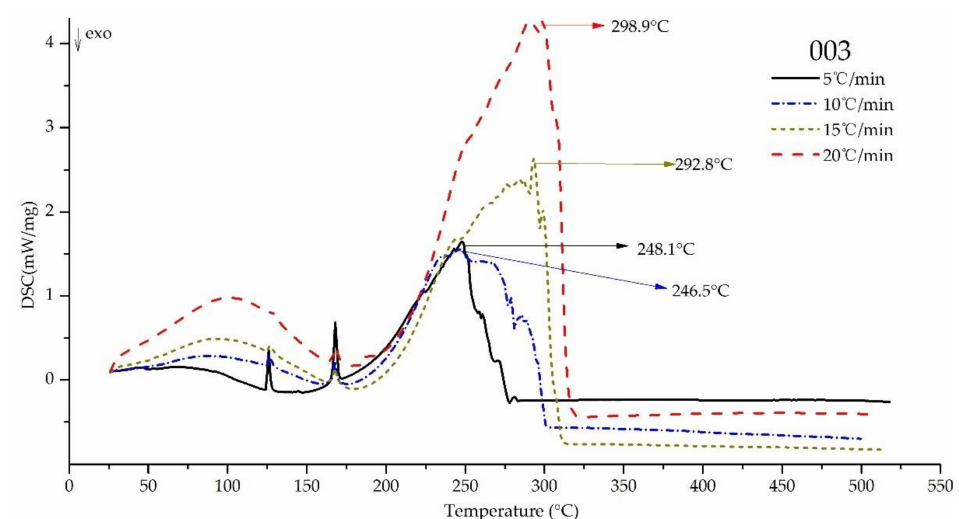
Figure 2. The DSC of the emulsion explosives matrix samples 000 to 003 at different heating rates under a nitrogen